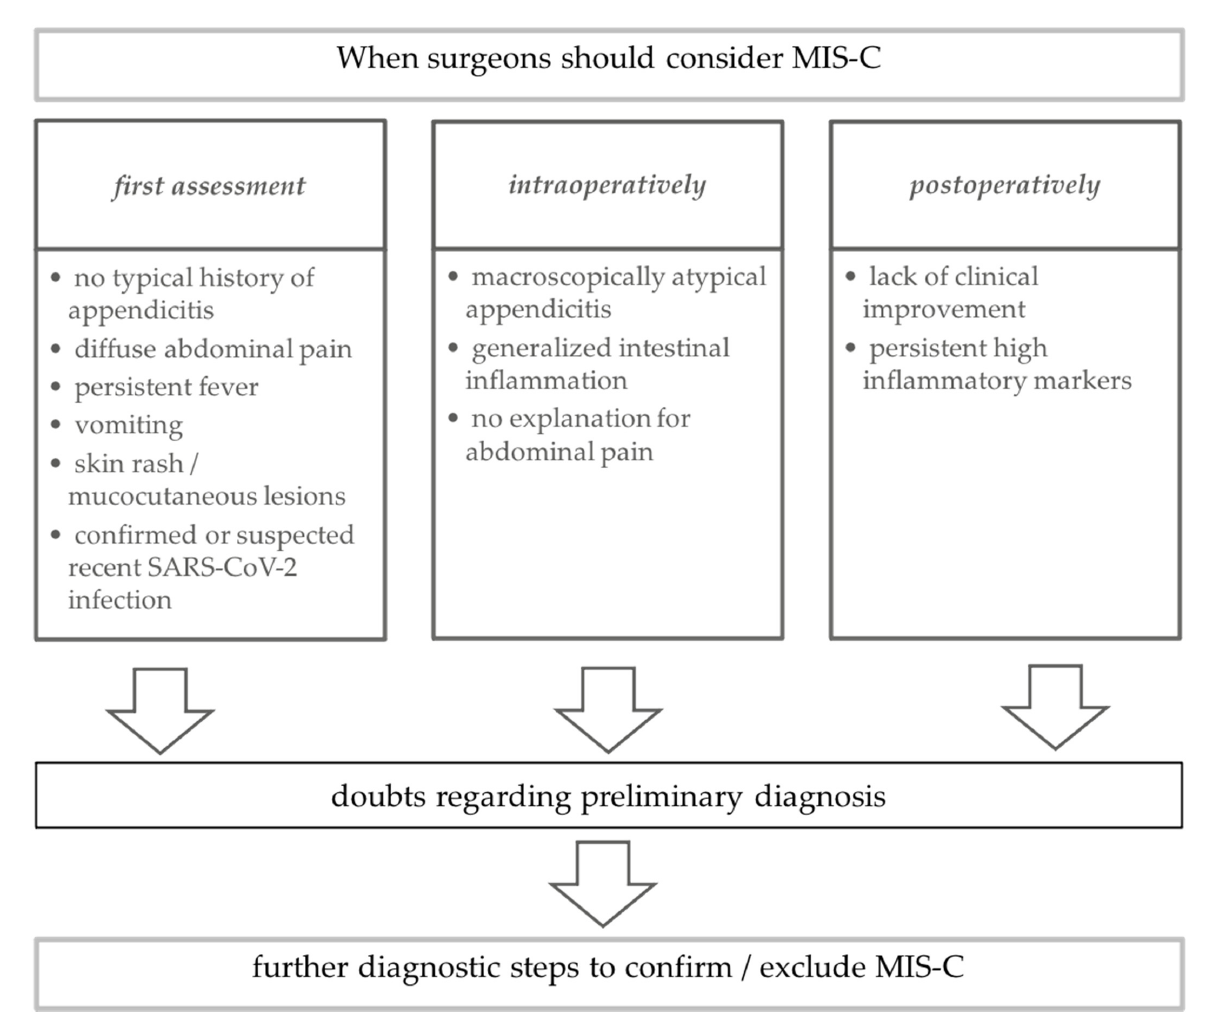
Figure 2. Surgical algorithm for children with typical and atypical abdominal pain regarding differential diagnosis of MIS-C.